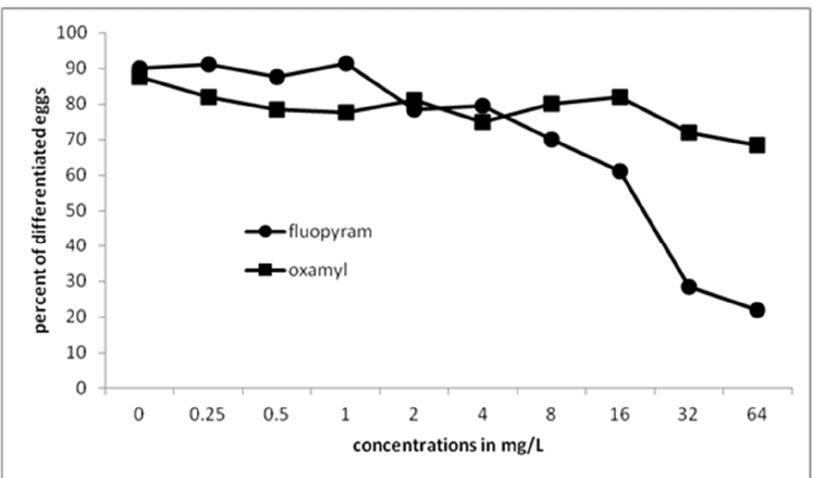
Figure 2. Differentiation of Meloidogyne javanica eggs when affected by different doses of fluopyram or oxamyl after immersion of 50 undifferentiated eggs in test solutions for 28 days. Values are means of five replicates.